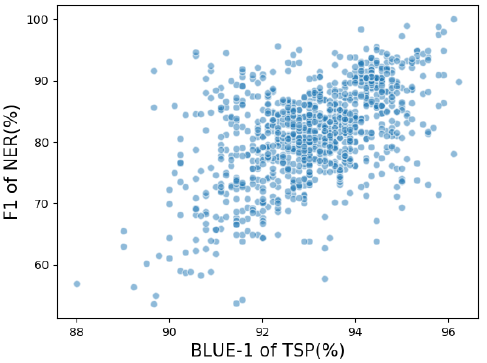
Figure 6. The scatter graph of F 1 of NER over accuracy of TSP on the OntoNotes test